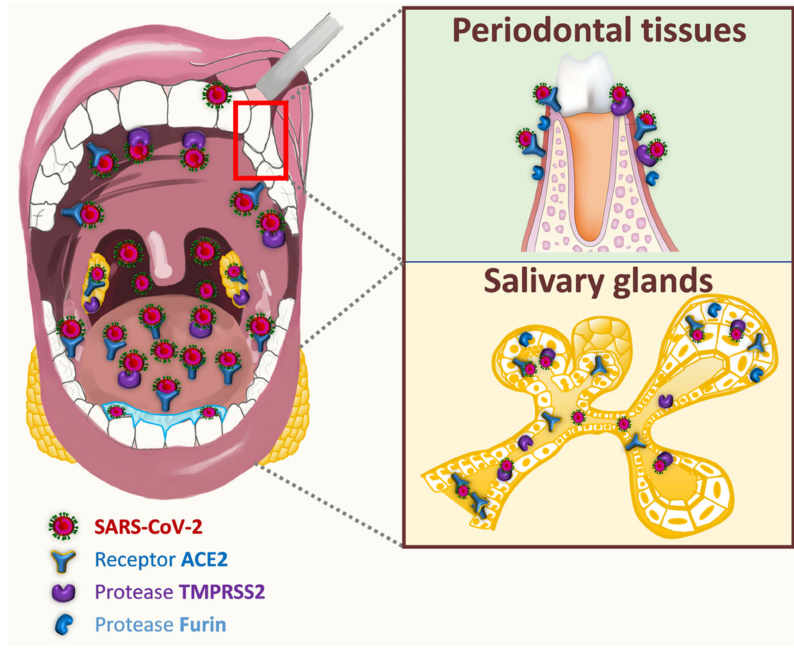
Figure 1. Potential entry routes for